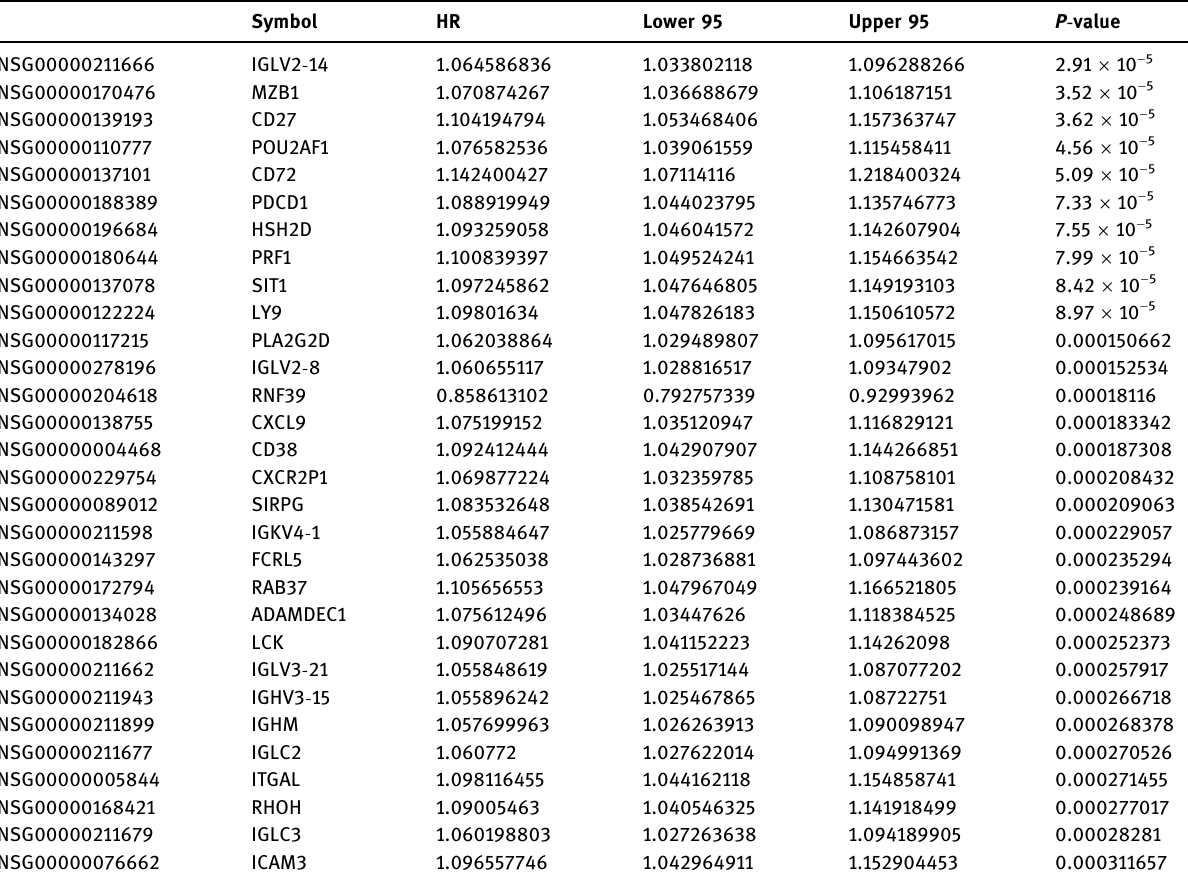
Table 1: Top30 genes signi fi cantly a ff ect the overall survival time of patients by survival analysis